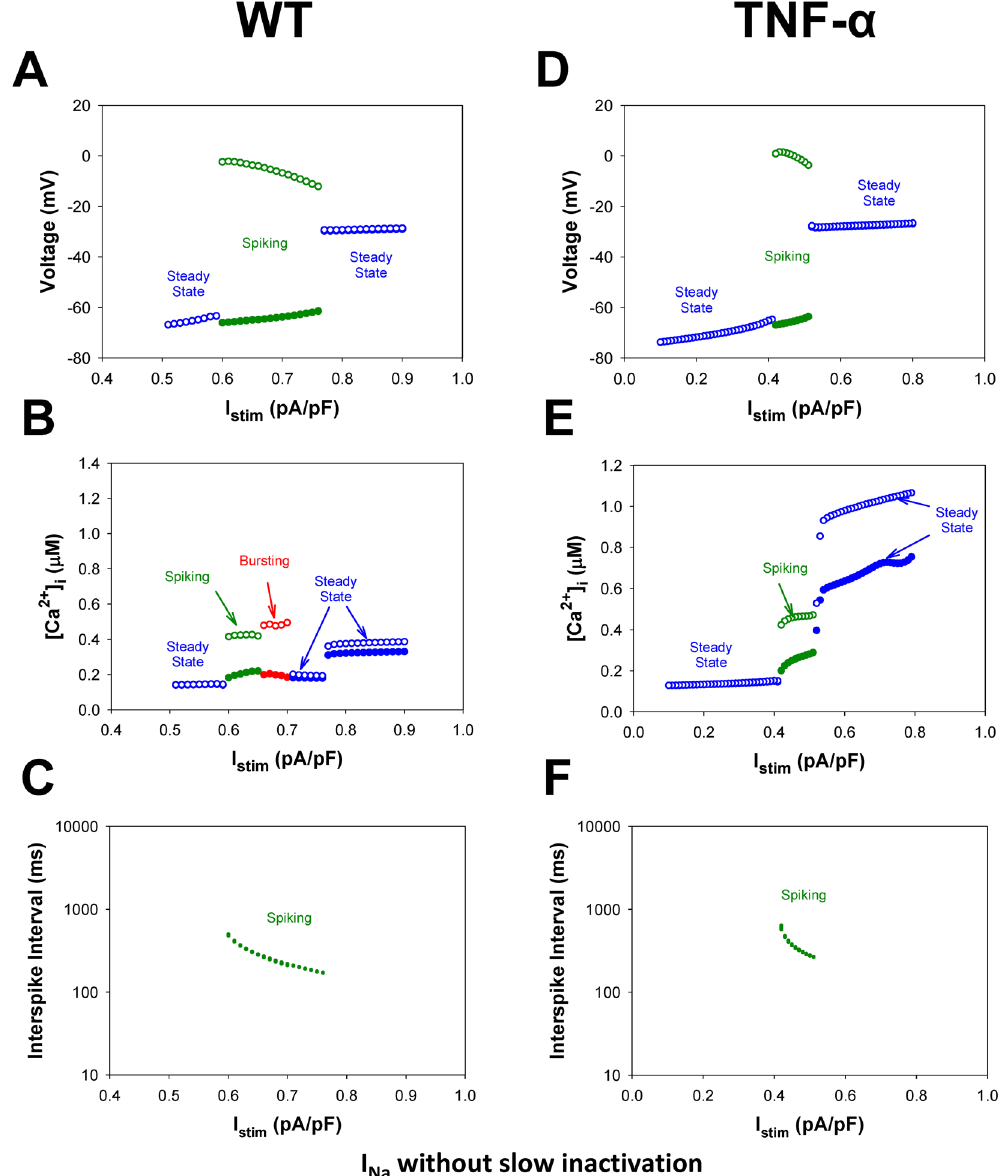
Figure 11. Simulated dependences of AP amplitudes (Panels A,D), [Ca 2 + ] i transients (Panels B,E), and interspike intervals (Panels C,F) for the ventricular myocytes from WT (Panels A–C) and TG (Panels D–F) mice on steady-state injected current I stim . Bursting activity of AP is absent (Panels A,D). AP amplitude, [Ca 2 + ] i transients, and interspike intervals were calculated in time interval from 40 to 50 s. For calculation of interspike intervals the threshold potential was set to V th = − 40 mV. I Na without slow